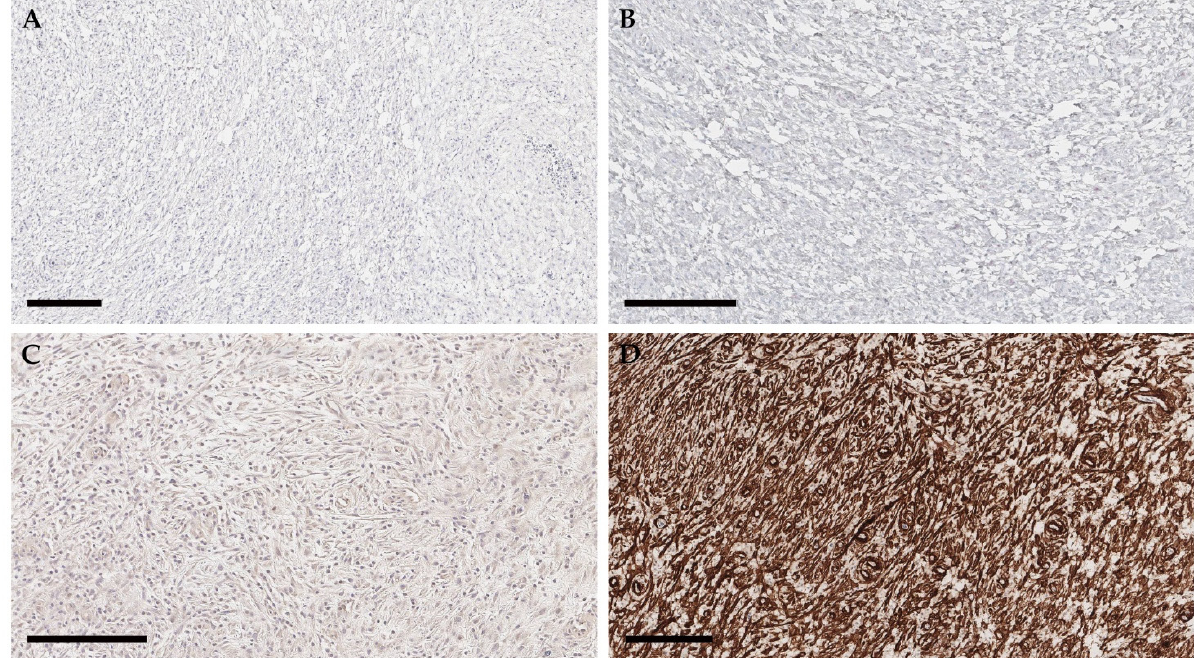
Figure 5. Immunohistochemistry of the mass (scale bar = 200 μ m). Immunohistochemical staining of the mass. The tumor cells were negative for desmin ( A ) and vimentin ( B ), weakly positive for S100 ( C ), and robustly positive for smooth muscle actin ( D ).